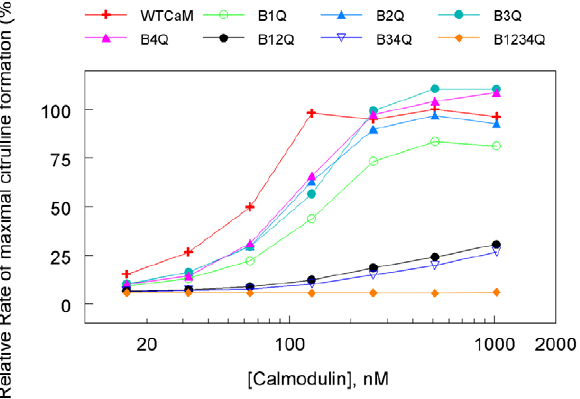
Figure 2. Citrulline formation as a function of CaM concentra- tions. Citrulline forming activity was determined in a reaction mixture containing 25 mM Tris, pH 7.5, 100 nM eNOS, 3H-L-arginine ( 1 m Ci), L- arginine (20 m M), NADPH (100 m M), H 4 B (10 m M), and CaCl 2 (300 m M), 0.2 mM EDTA, 100 mM NaCl, 0.1 mM DTT, 10% glycerol and the indicated concentration of each CaM construct as described under